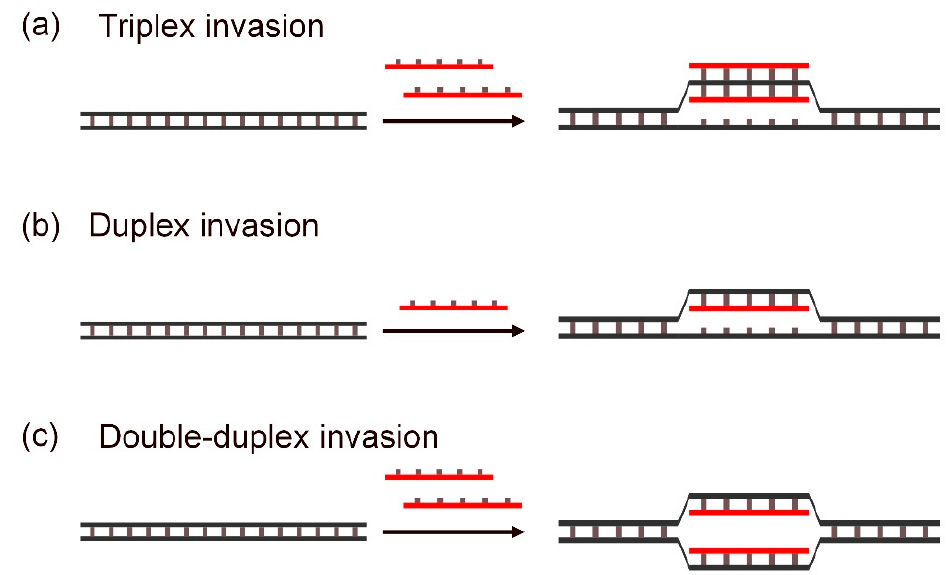
Figure 4. Various recognition modes of target dsDNA by PNA: ( a ) triplex invasion; ( b ) duplex invasion; and ( c ) double-duplex invasion.